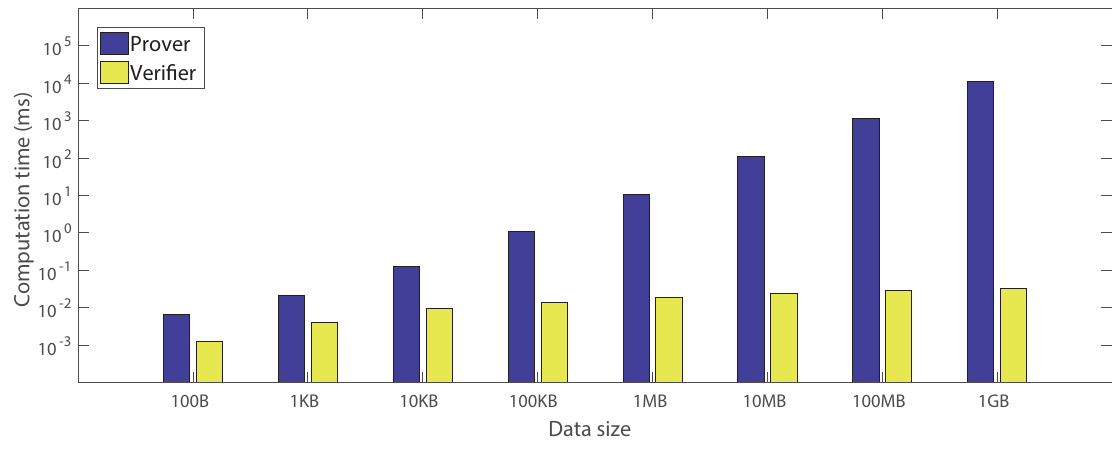
Figure 5. Computation time for Merkle tree-based